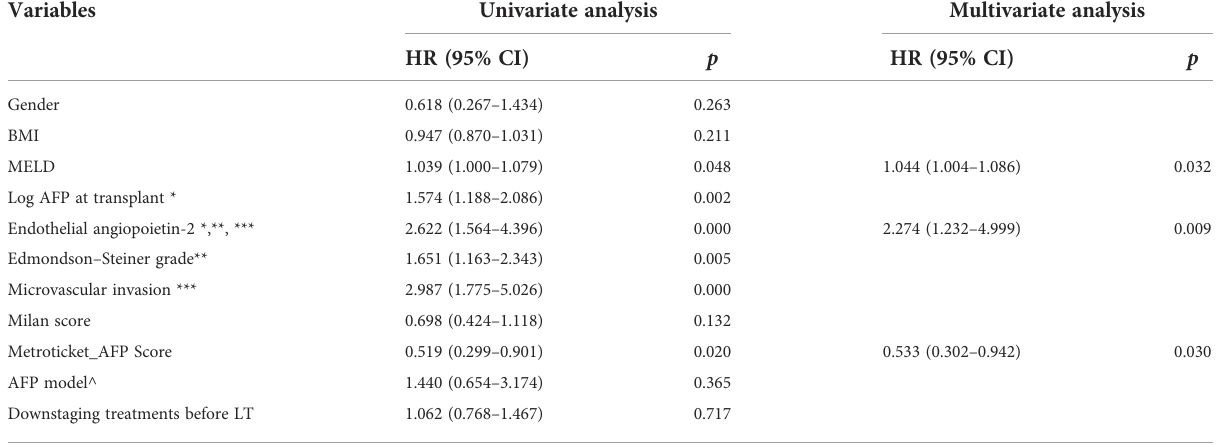
TABLE 4 Univariate and multivariate analysis results for the survival of HCC after LT in the training cohort.